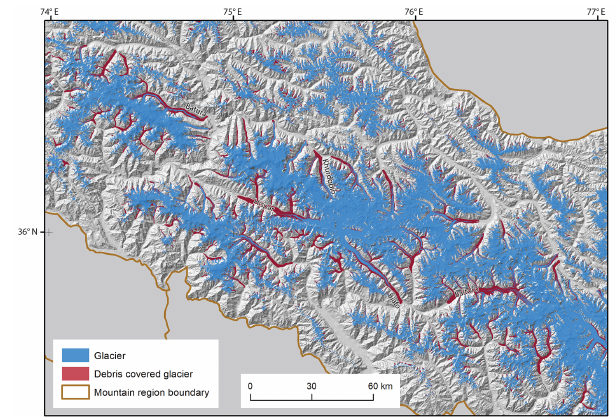
Figure 13. Debris cover on glaciers in the central